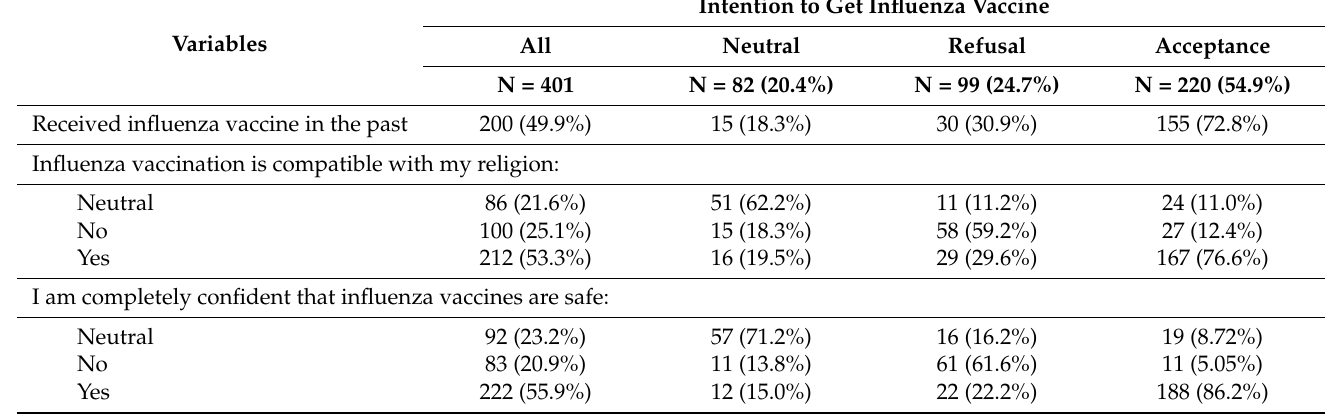
Table 2. Attitudes toward influenza vaccination of 401 healthcare professionals in Cape Town,